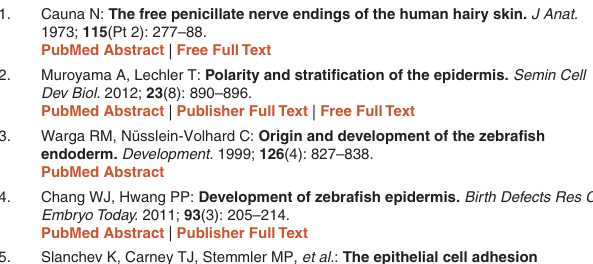
Figure 2–Figure 4 https://doi.org/10.5256/f1000research.15932. d236505